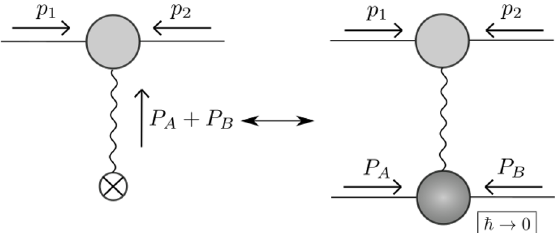
Figure 2. Equivalence between wave scattering on point-particle backgrounds and the four-point function, where the background is effectively identified with the classical limit of the dark gray interaction vertex of the four-point